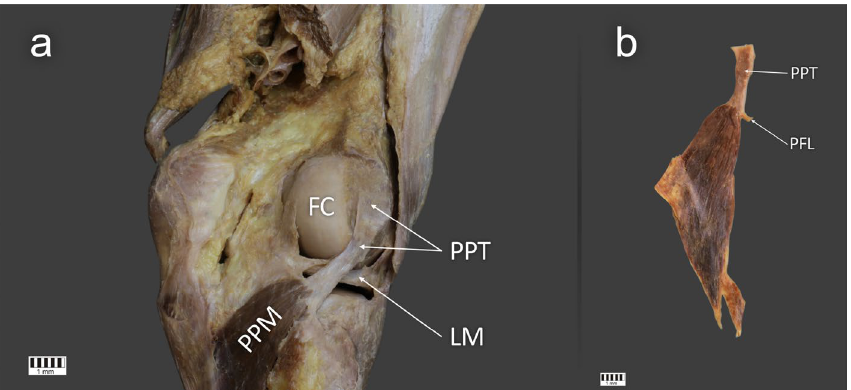
Figure 1. Type I of the popliteus tendon attachment. ( a ) Posterior view of the right knee joint with Type I of the popliteus tendon. ( b ) Isolated popliteus muscle with Type I of the popliteus tendon. PFL—popliteofibular ligament, PPT—popliteus tendon, FC—femoral condyle, LM—lateral meniscus PPM—popliteus muscle. The Fig. 1 was taken with Canon EOS 6D camera with Canon EF 100 mm f/2.8 L Macro Is USM, and the signatures were made in Corel DRAW 12 (https:// www. corel draw. com/ pl/ pages/ corel draw-